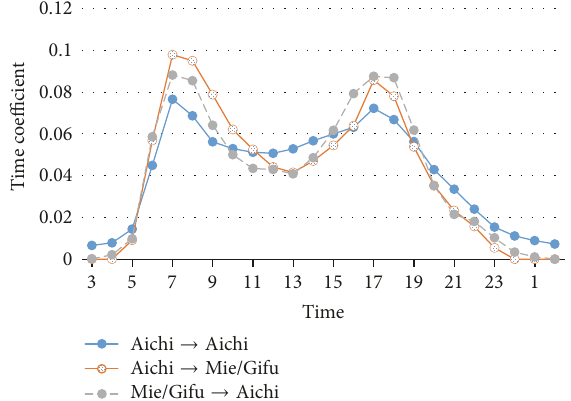
Figure 11: Hourly variation patterns for TCoE result of three